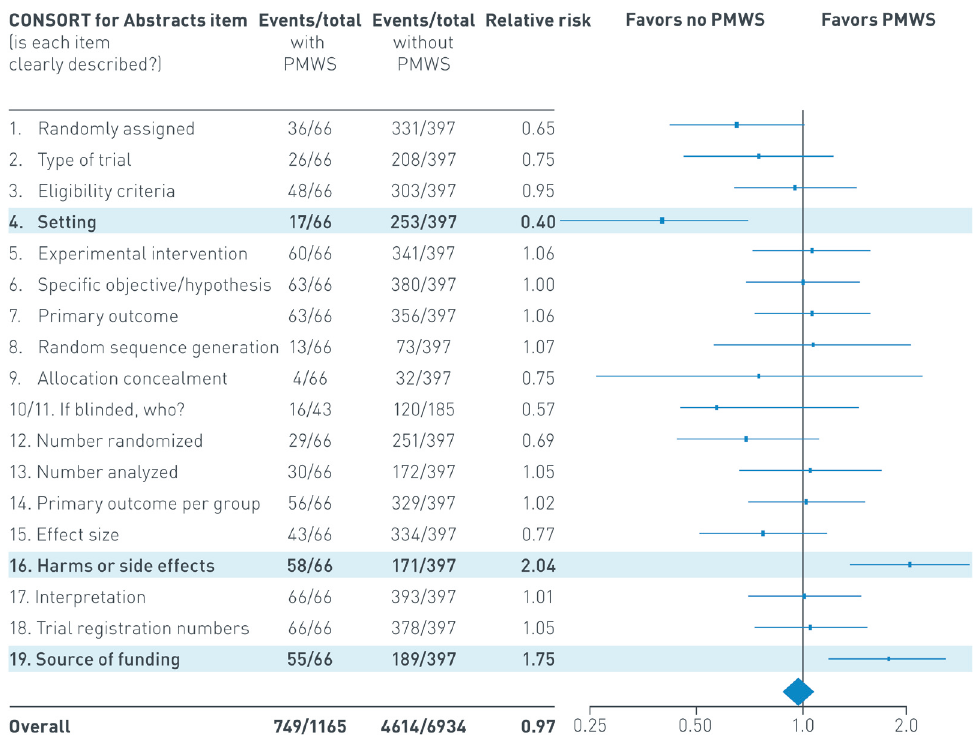
Figure 1. Reporting of CONSORT for Abstracts items in articles with and without acknowledged professional medical writing support. CONSORT, Consolidated Standards of Reporting Trials; PMWS, professional medical writing support. Significant associations are shaded.